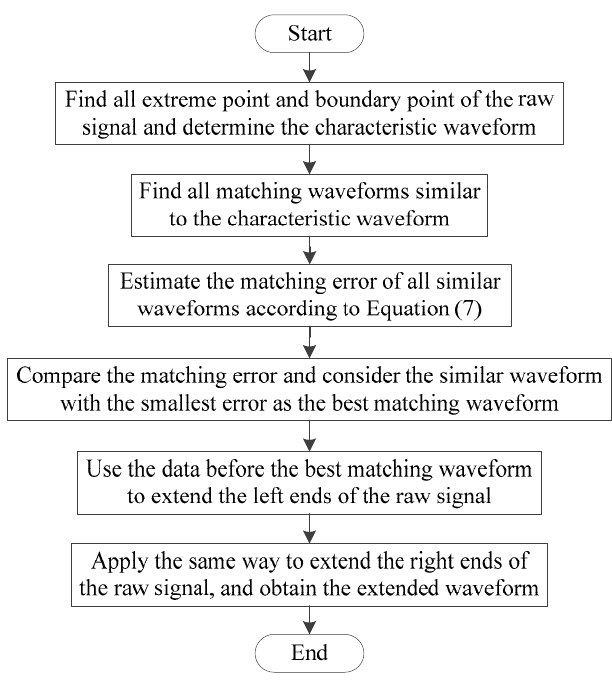
Figure 1. Flowchart of the waveform matching extension.